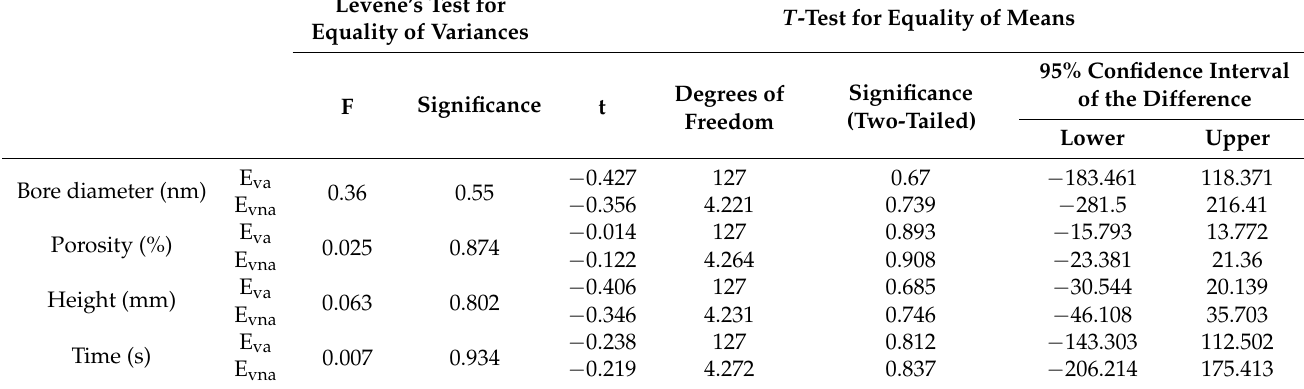
Table 3. Independent-samples T -test